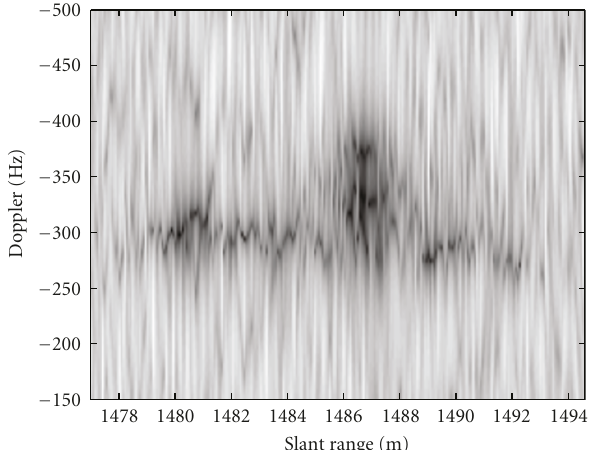
Figure 12: ISAR image obtained by applying AR coe ffi cients to the real